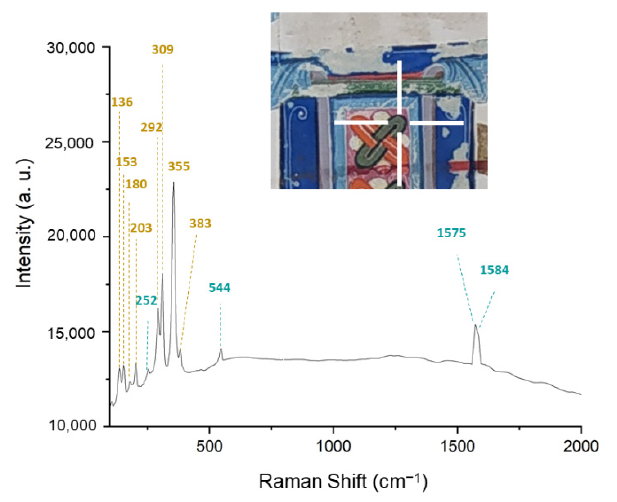
Figure 6. Raman spectrum of a green decorative element in the frame of the initial “P” (displayed inside the white cross). The peaks of orpiment are reported in yellow colour, those of indigo are indicated with a green colour.